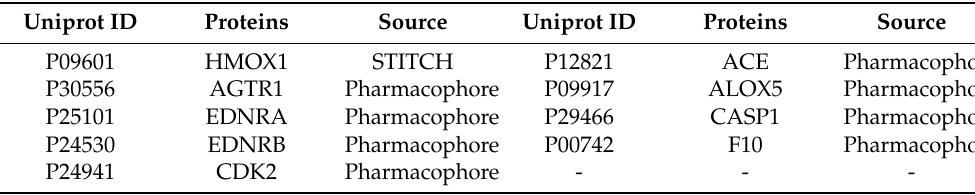
Table 1. Proteins information of Danshensu (DSS).